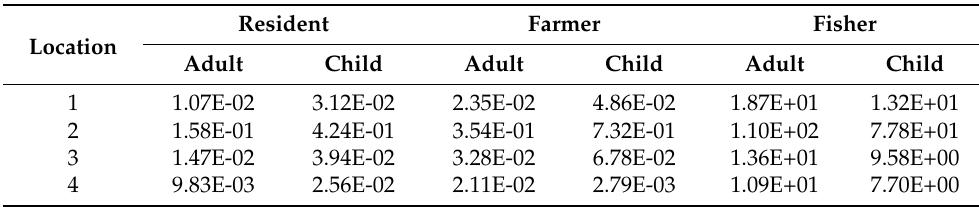
Table 7. Total non-cancer hazards estimated for each receptor population, for COPC and overall exposure pathways for all locations of study.